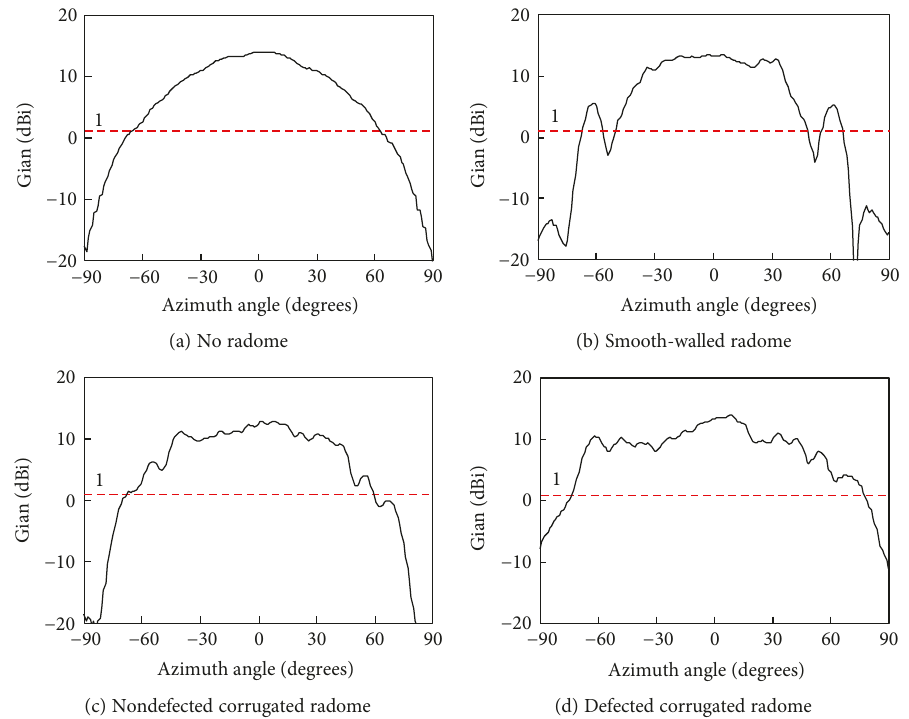
Figure 19: Measured radiation patterns of Ch. 3 at 76.5 GHz when radomes having di ff erent inner surfaces are